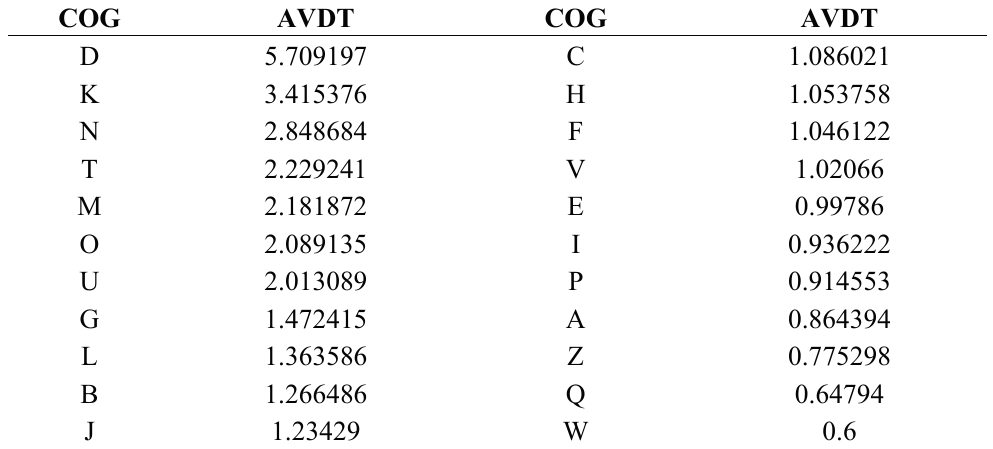
Table 4. Average value of discrepant times (AVDT) between strong-biased group and week-biased group for each functional subcategory in descending order.